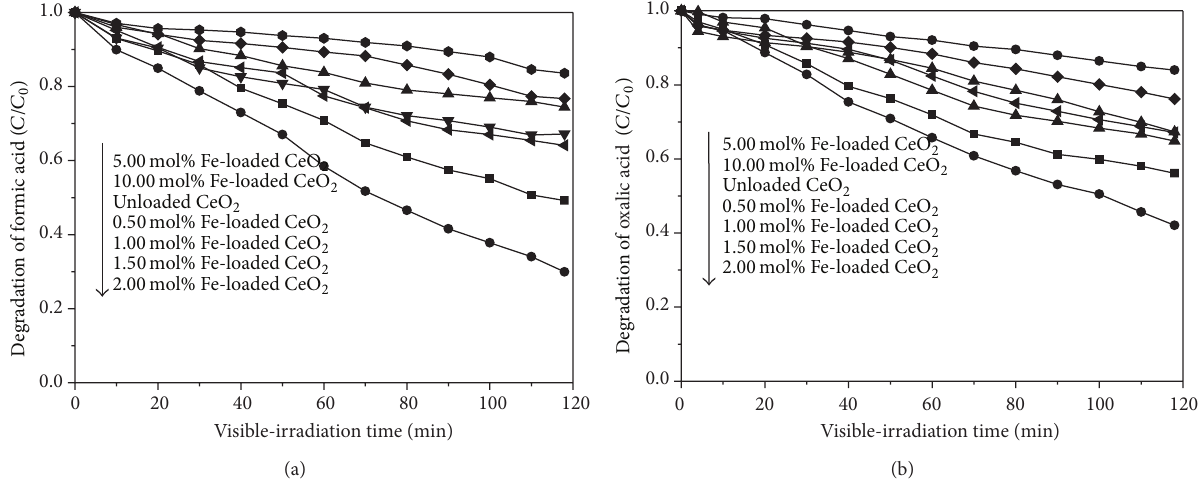
Figure 5: Photocatalytic degradation of (a) formic acid and (b) oxalic acid by CeO 2 with different iron content as a function of visible-light irradiation